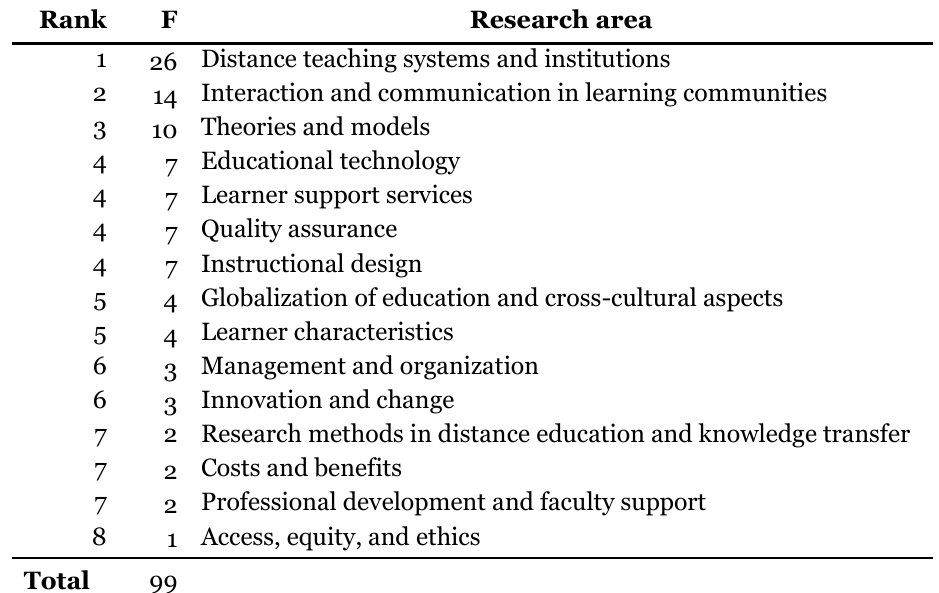
Distribution of Research Areas From 2000–2005 (N = 99)